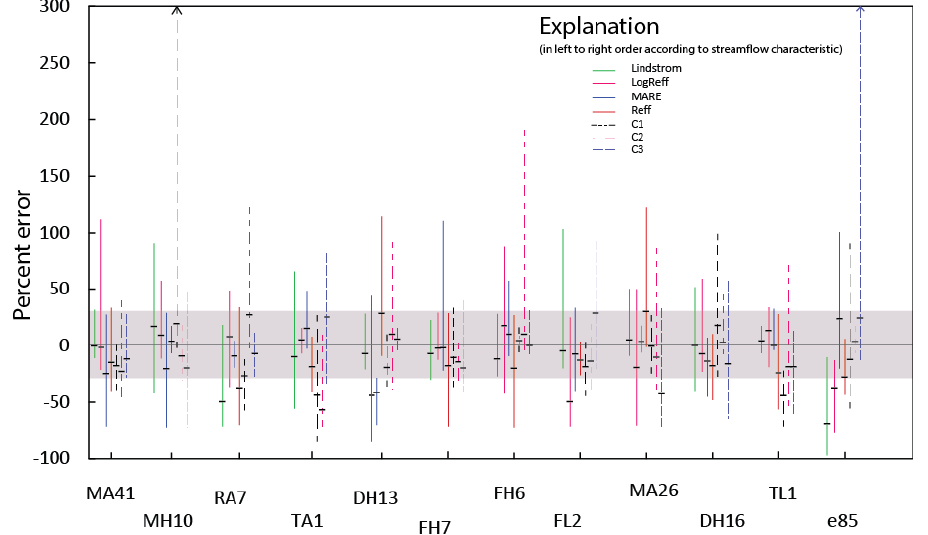
Figure 7. Minimum, maximum, and median percent errors according to objective function and streamflow characteristic for calibration period 1 (Cal1). Each vertical bar is based on the median error for the 27 catchments. The gray band in the center of the figure represents ±30 percent difference [46] Vertical bars with arrows indicate the maximum percent error exceeded the axis